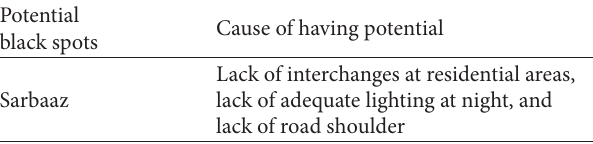
Table 1: Section 1: Iraanshahr-Polchamani.